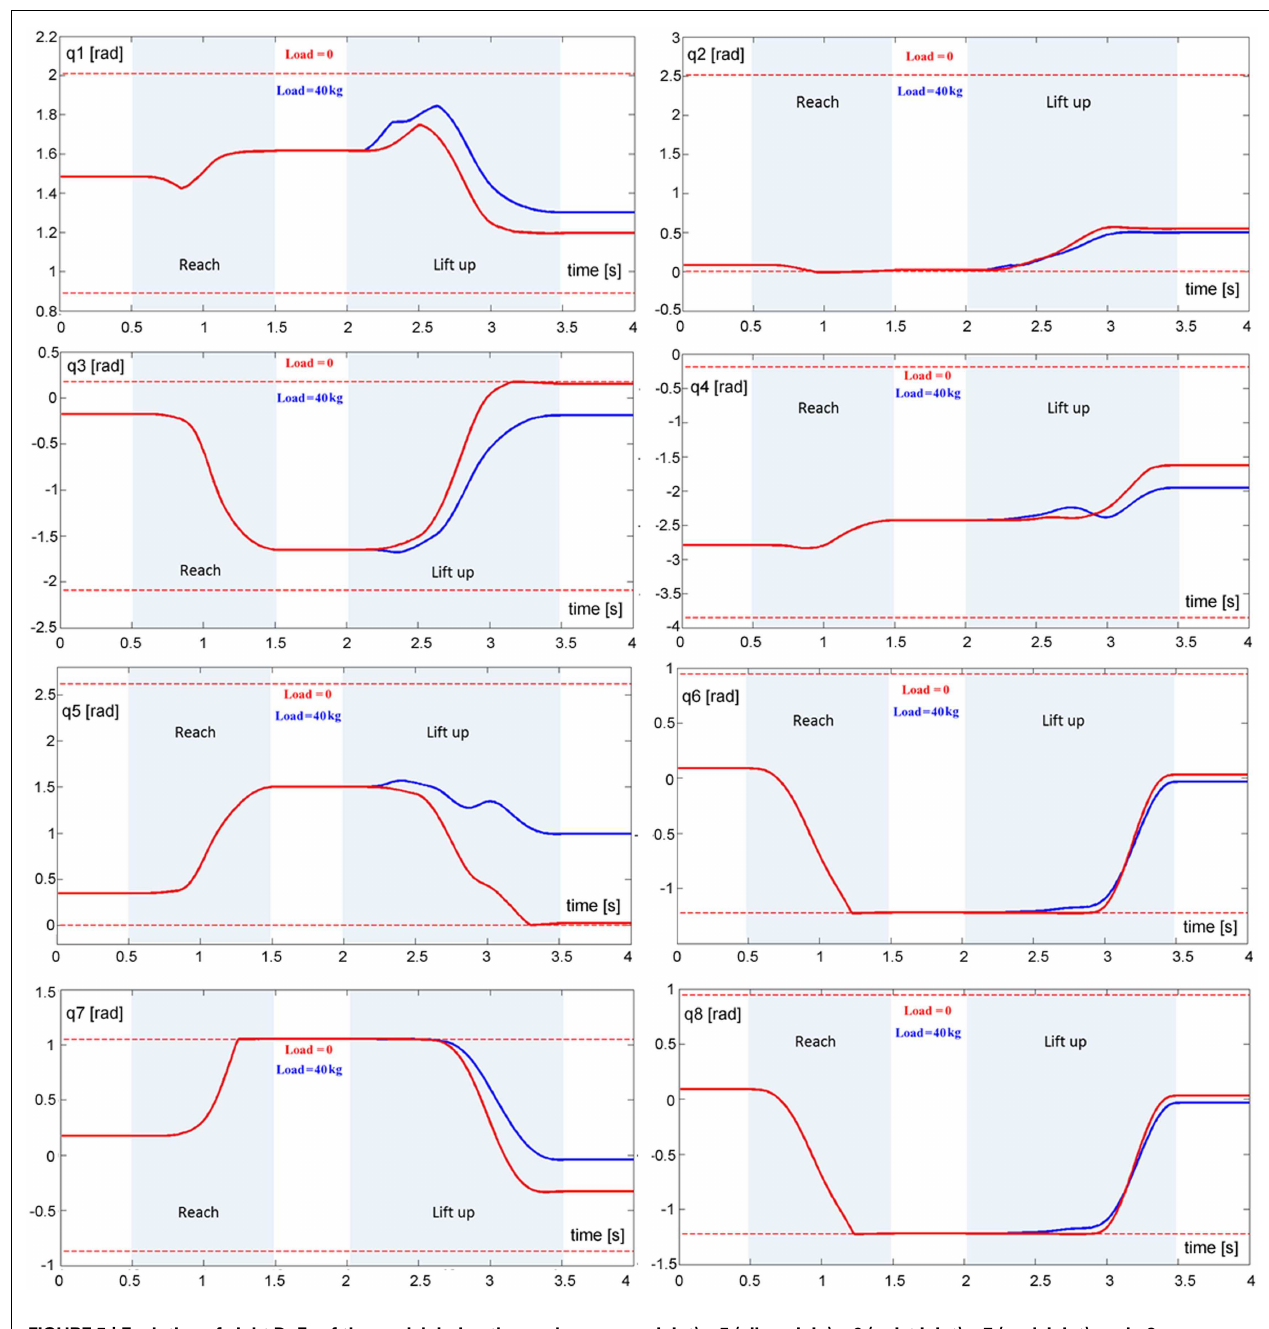
FIGURE 5 | Evolution of eight DoFs of the model during the reach and lift task for two loads, namely 0kg (red trace) and 40kg (blue trace): q1 (ankle joint), q2 (knee joint), q3 (hip joint), q4 (shoulder